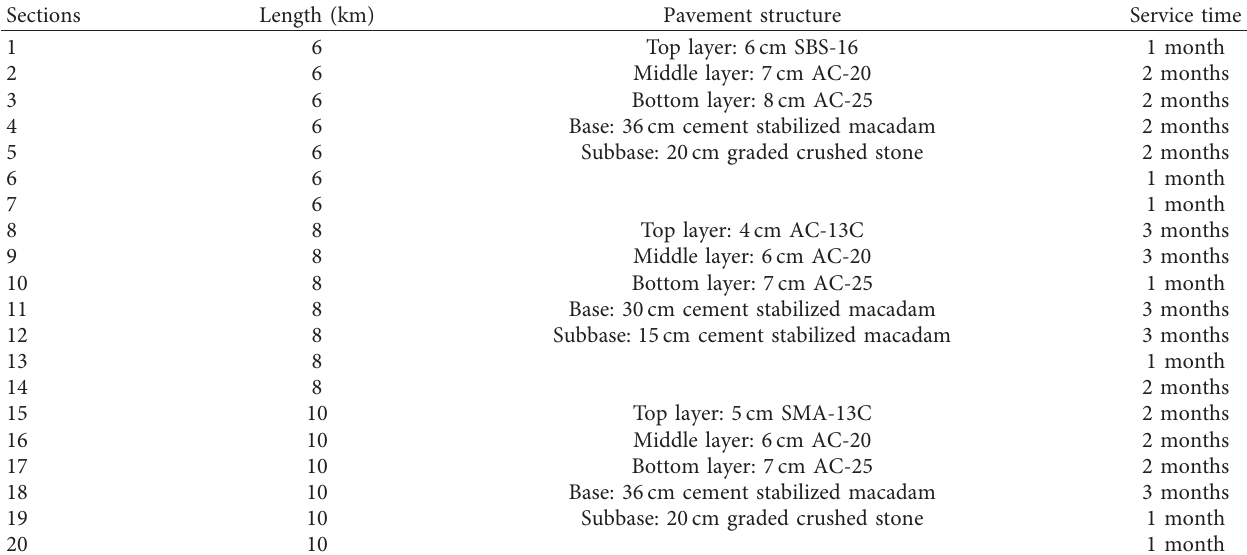
Table 10: The test section